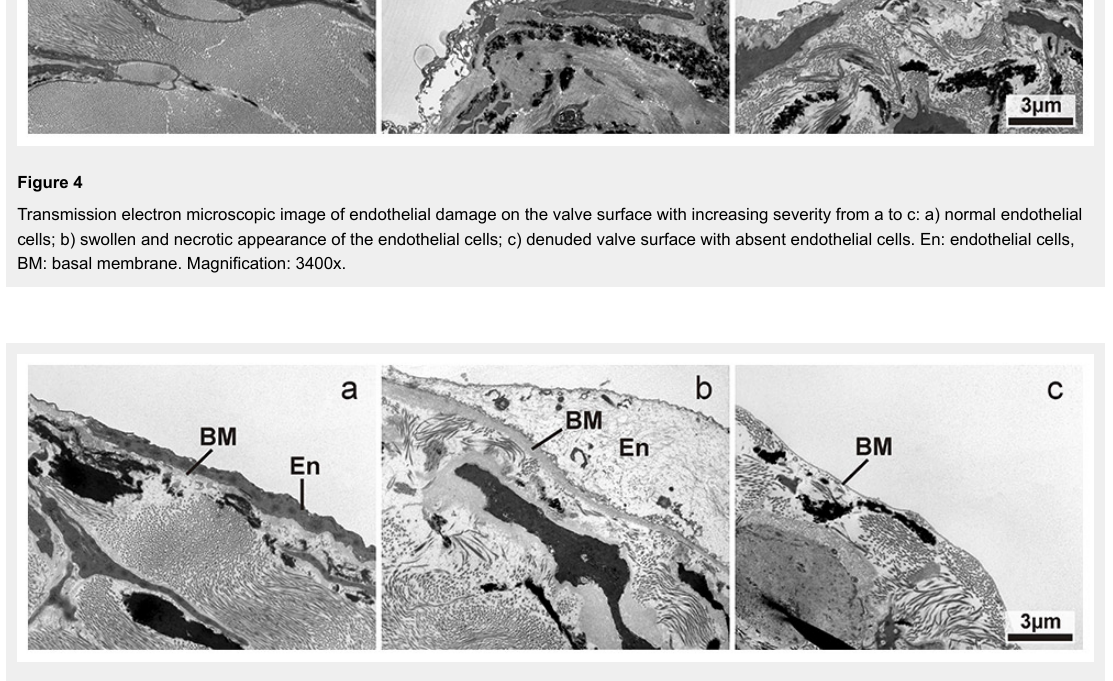
Transmission electron microscopic image of endothelial damage on vessel wall surface near a valves surface with increasing severity from a to c: a) normal endothelial cells; b) drastically swollen and necrotic appearance of the endothelial cells, basal membrane is also swollen; c) denuded vessel wall surface with absent endothelial cells showing direct contact of the basal membrane with the vessel lumen. En: endothelial cells, BM: basal membrane. Magnification: